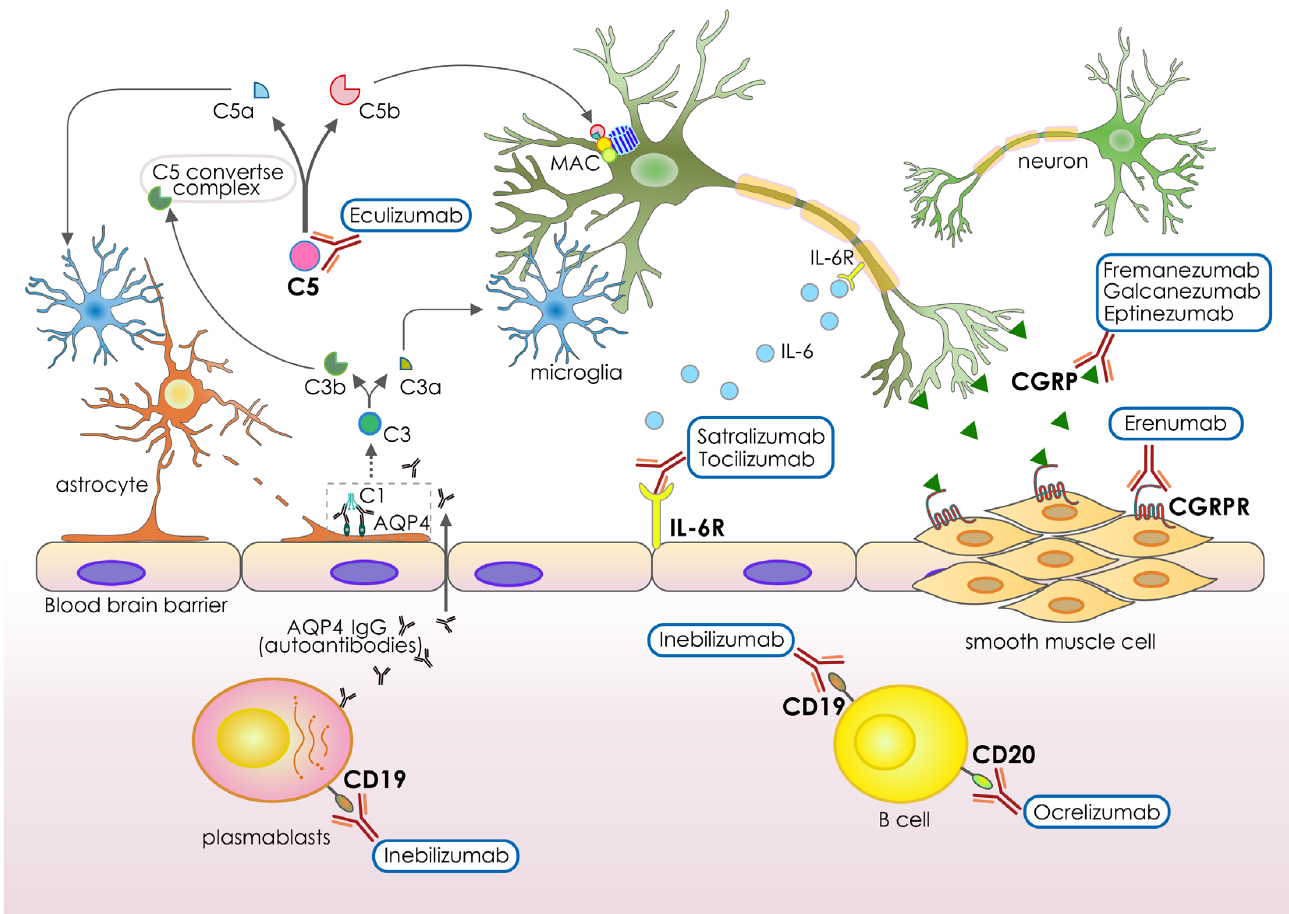
Figure 2. Schematic representative of recently developed antibody-based drug in different neurological diseases. Antibody-based drugs exert their therapeutic effects through a variety of mechanisms. Some antibodies block the function of the membrane receptors. Others target specific complement proteins for cell depletion. Finally, antibody-based drugs can target specific effector molecules from interacting with their ligands. Immunogens include IL-6L/R, interleukin 6 ligand/receptor; CGRPL/R: calcitonin gene-related peptide ligand/receptor; CD19/20: cluster of differentiation 19/20; C5: complement factor 5 Table 1. Antibody-based drugs approved during 2017–2021 for neurological disorders.